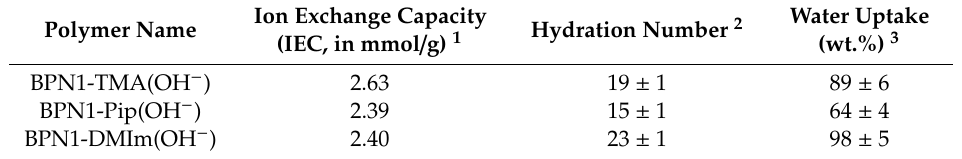
Table2. Ion exchange capacity(IEC), hydration number, and water uptake of BPN1-QA(OH − )